Question: In a single sentence, describe what this figure presents.
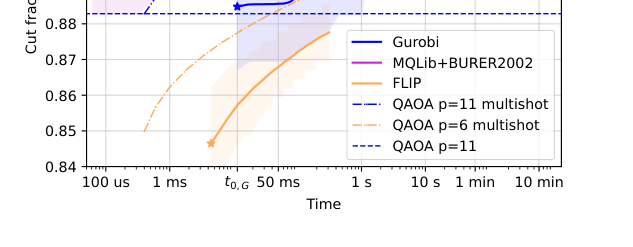
Answer: Evolution of cut fraction value in the process of running the classical algorithms solving 3-regular MaxCut with N=256. The shaded area shows 90-10 percentiles in- terval, and the solid line shows the mean cut fraction over 100 graphs. The dashed lines show the expectation value of single-shot QAOA for p = 6, 11, and the dash-dotted lines show the expected performance for multishot QAOA given a sampling rate of 5 kHz. Note that for this N = 256 the multi-shot QAOA with p = 6 can compete with Gurobi at 50 milliseconds. However, the slope of the multi-shot line will decrease for larger N, reducing the utility of the multi-shot QAOA.